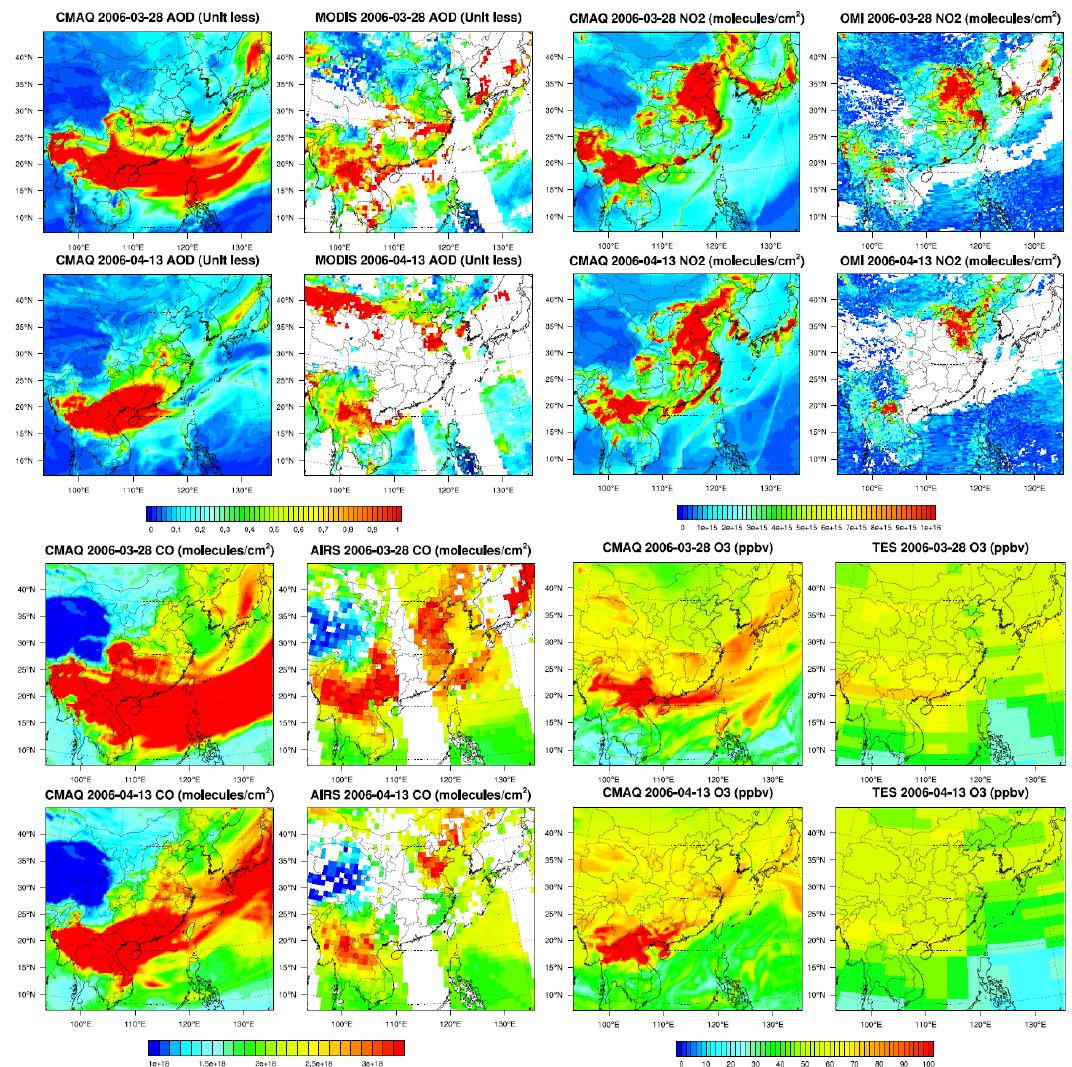
Figure 4. Continued. Fig. 4. Comparison between model simulated results and satellite products on 28 March and 13 April 2006, respectively. The evaluated satellite products include AOD, column NO 2 and CO concentration (moleculescm − 2 ) and O 3 concentration (ppbv) at around